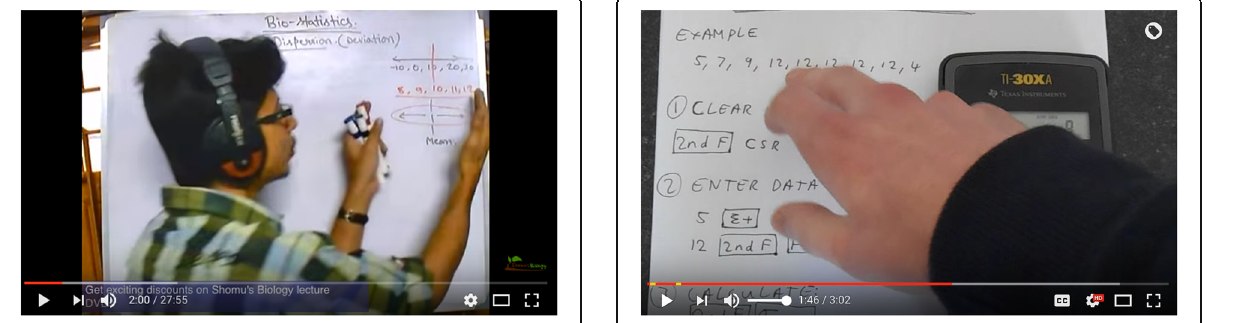
Fig. 3 Example of iconic gesture where speaker is indicating dispersion by using the space between two hands